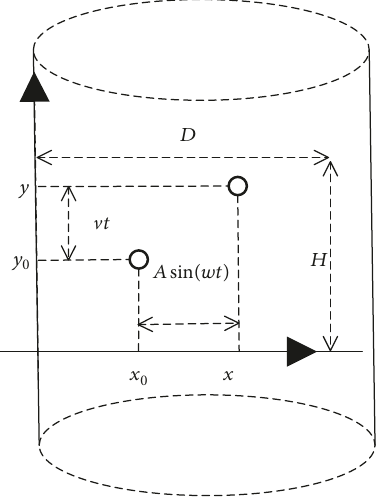
Figure 4: Simulation